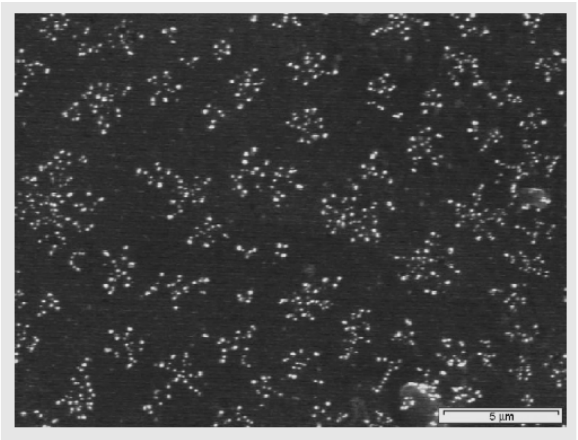
Figure 11. Fractal morphology of oxygen plasma-treated PVC (Reprinted with permission from [60]. Copyright 2007 Elsevier).